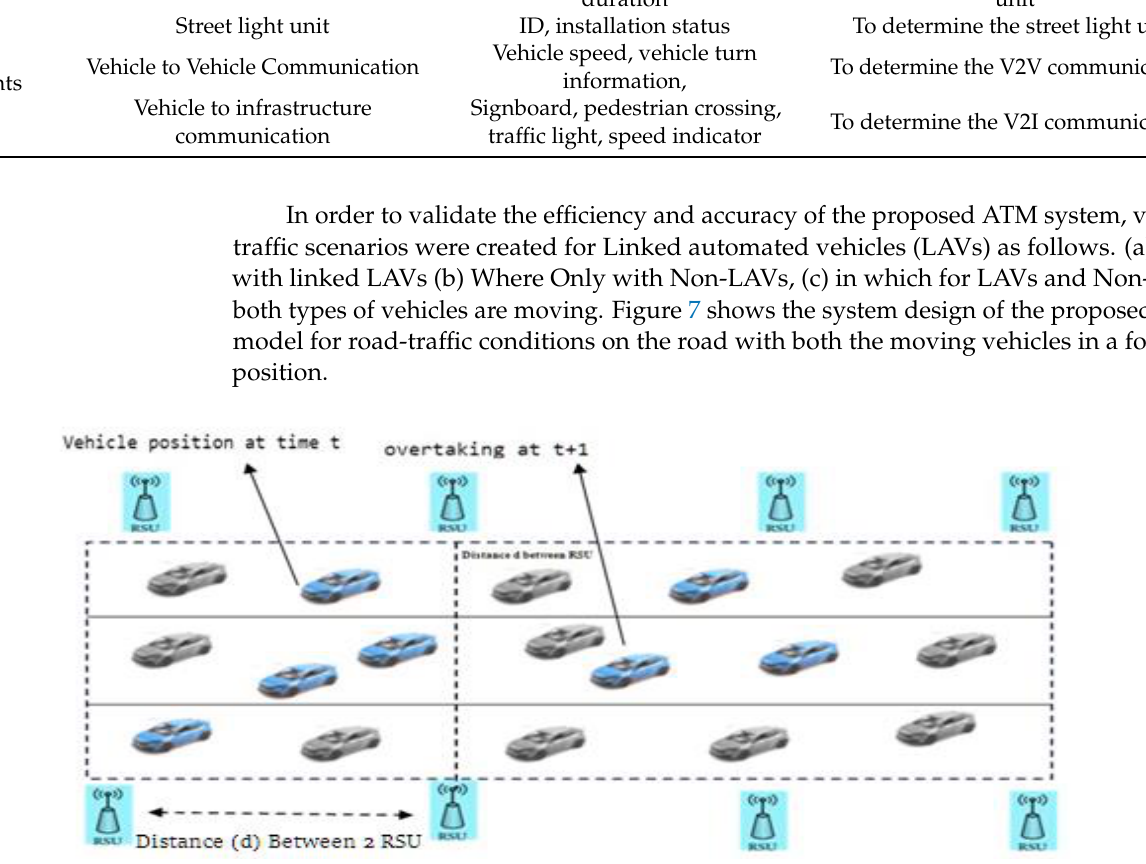
Table 2. Entities utilized in the proposed ATM system.